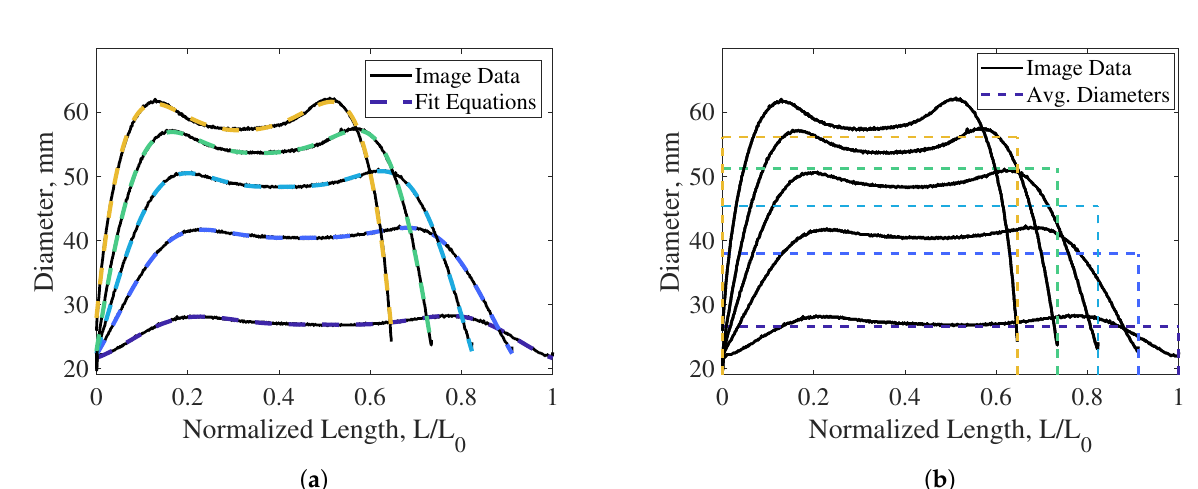
Figure 14. Comparison of assumed profiles to the measured shape profiles of the PAM at 0, 8.75, 17.5, 26.25, and 35 (maximum) percent contraction at 689kPa (100psi): ( a ) Three-term Fourier series fit equation profiles. ( b ) Assumed cylindrical profiles that have diameters equal to the average diameter of the respective measured shape profiles.